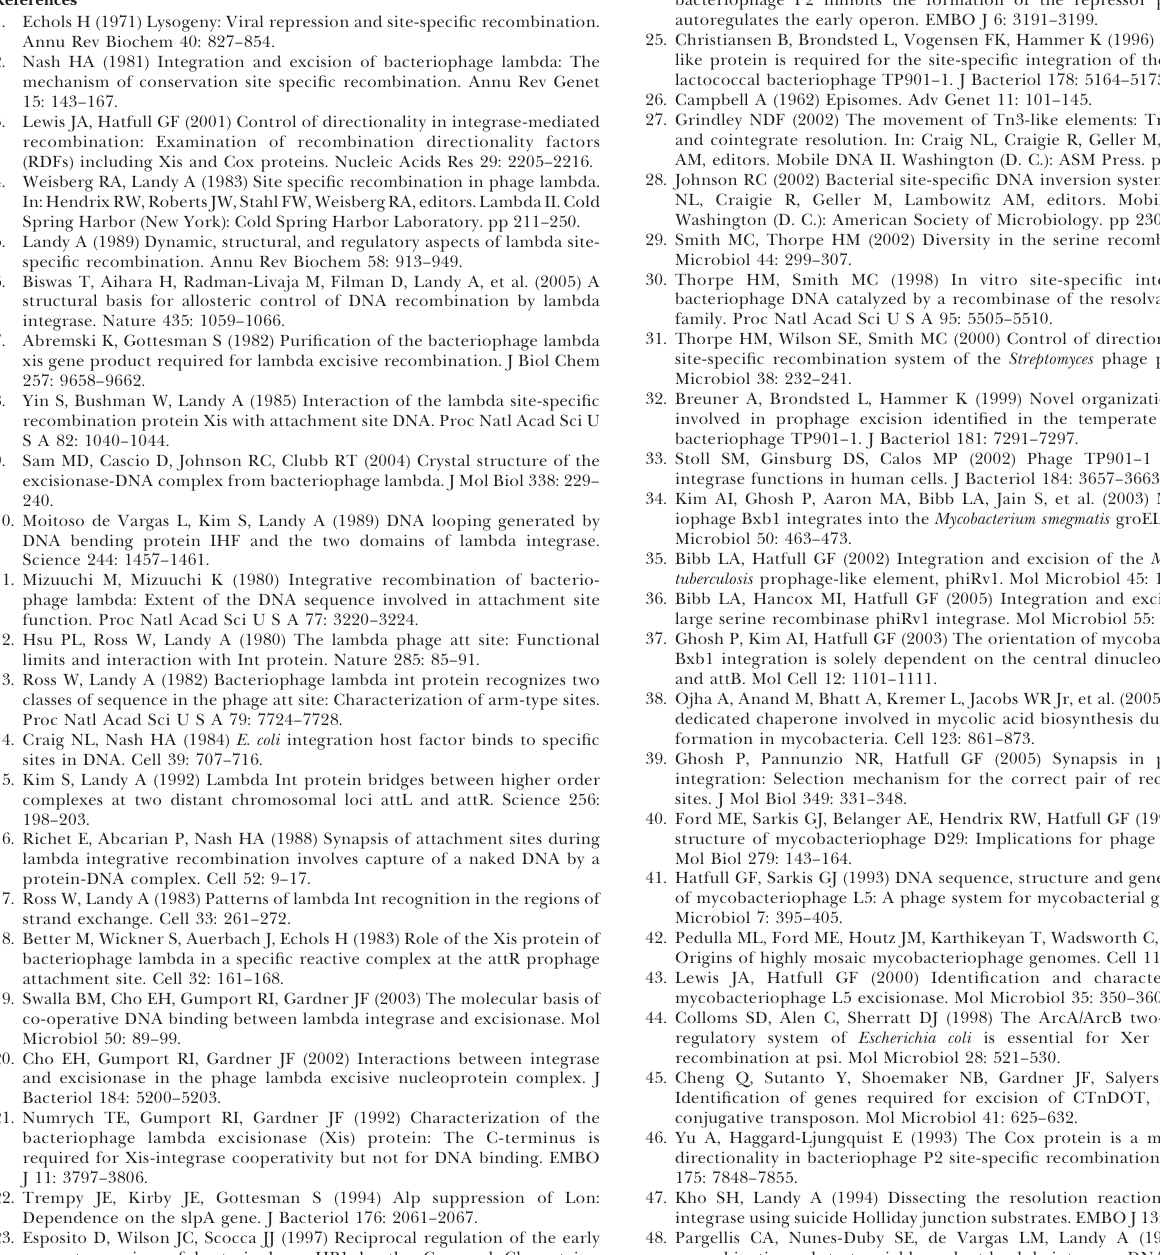
Figure S1. Identification of Bxb1 RDF Figure S2. In Vitro Excisive Recombination Using Short attL and attR Substrates Figure S3. DNaseI Footprinting of gpInt–DNA Complexes Found at DOI: 10.1371/journal.pbio.0040186.sg003 (5.4 MB TIF). Figure S4. Binding of gpInt and gp47 to Short DNA Substrates Found at DOI: 10.1371/journal.pbio.0040186.sg004 (2.8 MB